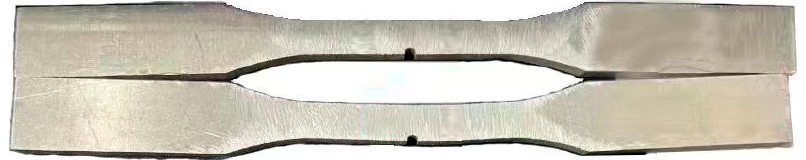
Figure 2. Comparison of deformed specimens of dissimilar lightweight materials welded joints with and without impact.